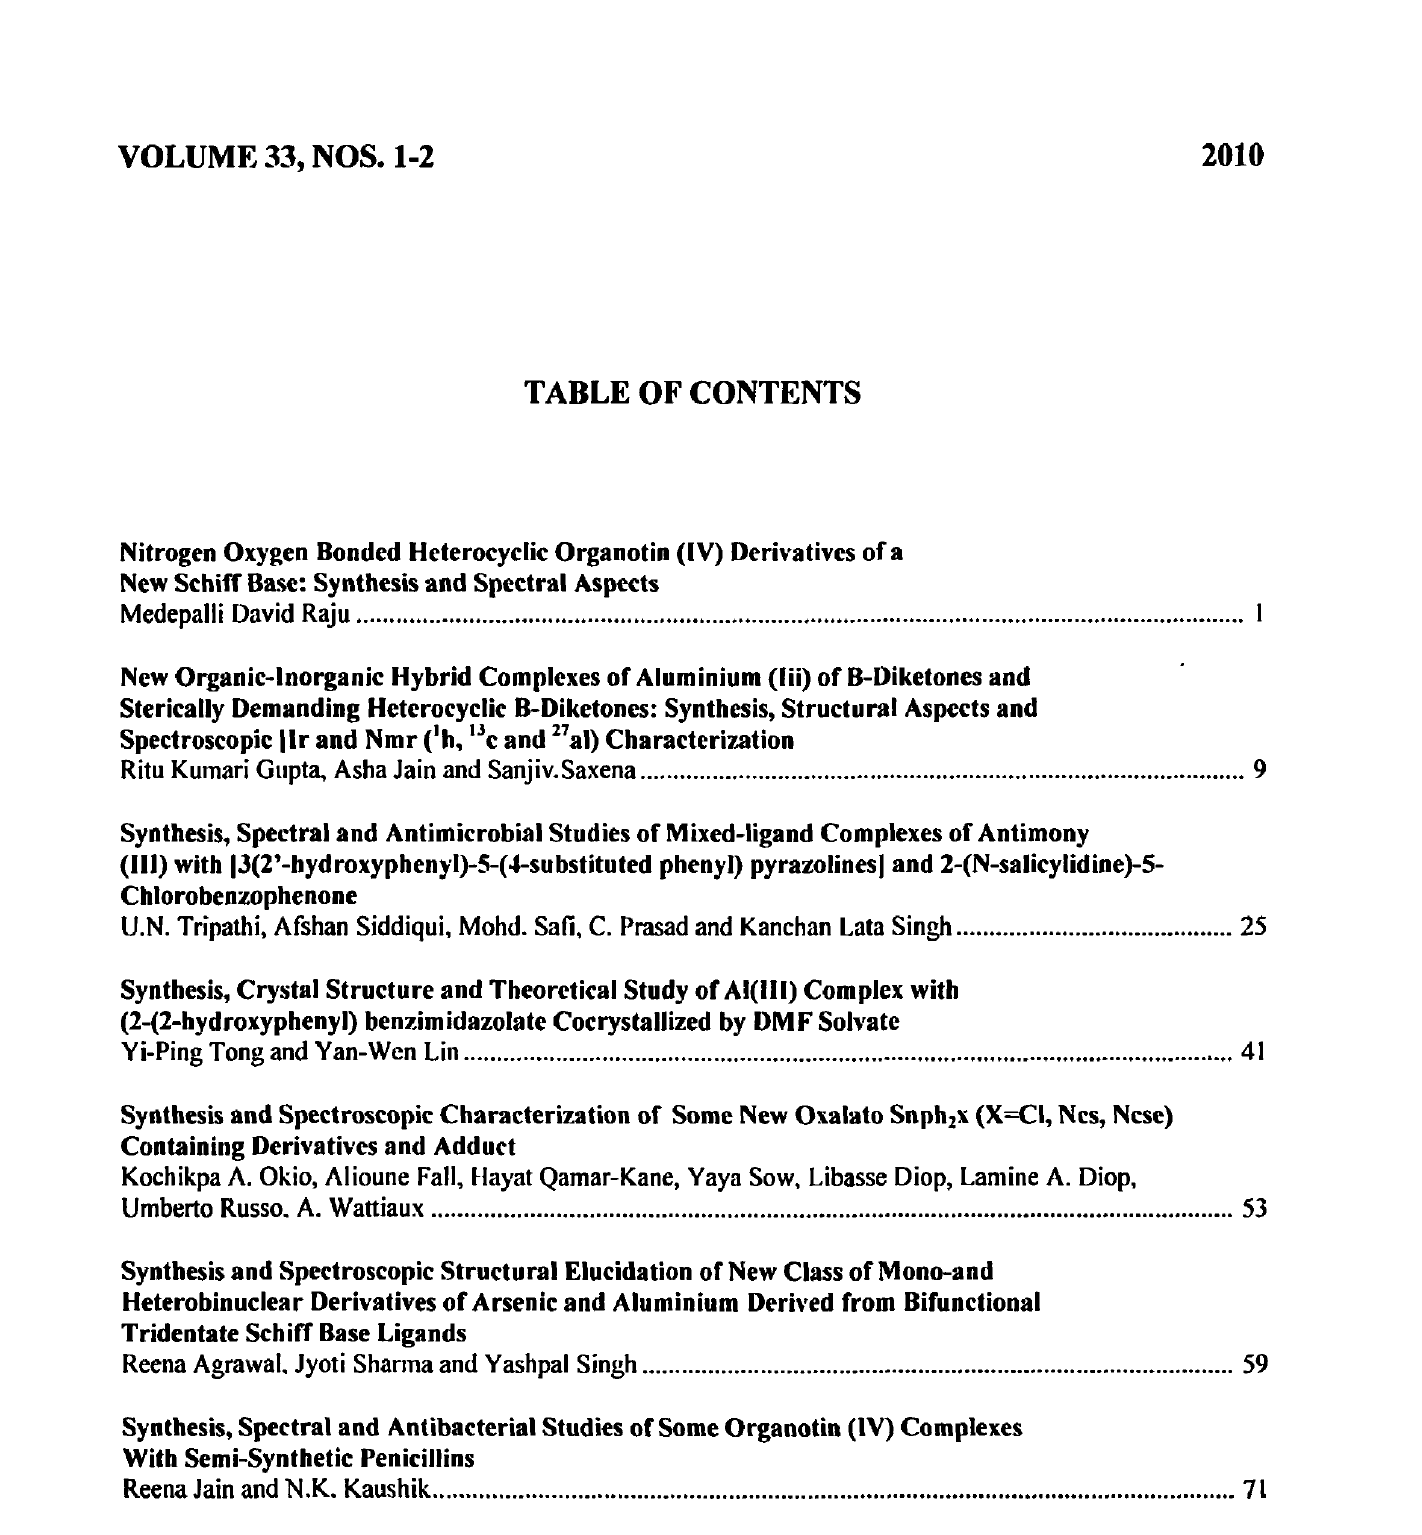
Containing Derivatives and